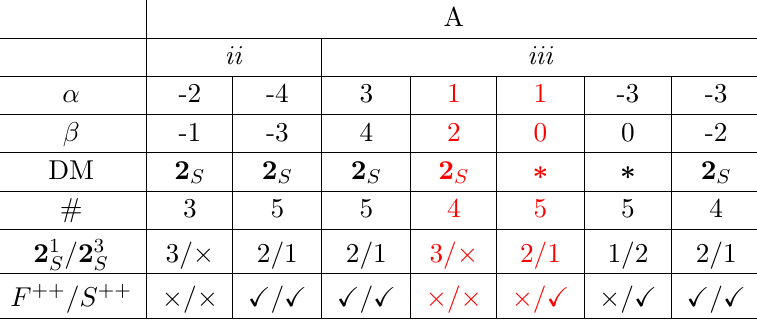
Table 24. Realizations of diagram 4.a of (cid:12)gure 4. For each set of SU ( 2 ) L quantum numbers (roman numerals) and Z 2 assignments (capital letters A, B, C) we give the hypercharge in terms of (cid:11) and (cid:12) parameters, the DM candidates, the number of beyond SM particles (#), the number of 2 1 and S 2 3 present as well as the existence (or not) of doubly-charged fermions ( F ++ ) and doubly-charged S scalars ( S ++ ) particles. The symbol X ( (cid:2) ) means present (absent) while the symbol (cid:3) , if present in the DM row, means mixing between 1 0 and 2 1 . The SU ( 2 ) L , Z 2 and U ( 1 ) Y assignments are S S given in table 22. In red we marked models with at least one even-charged Z 2 scalar doublet with hypercharge Y = 1 that generically can create